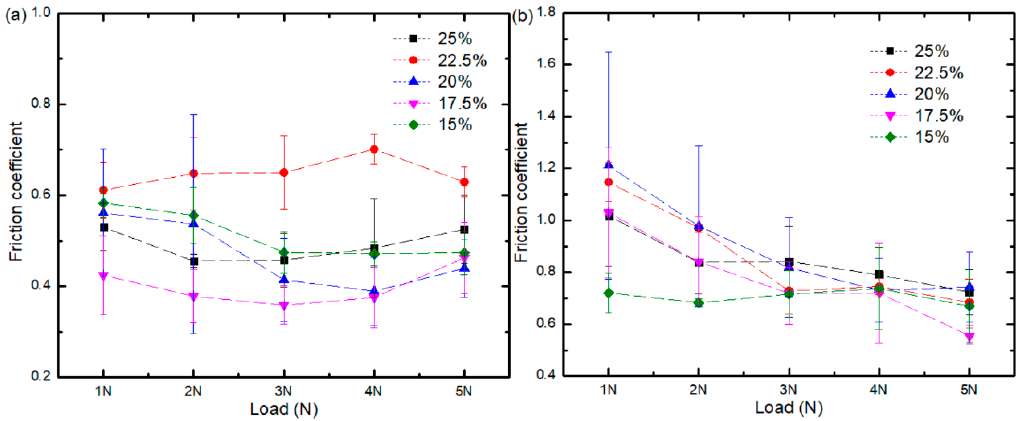
Figure 8. Variation curves of the friction coefficient of composites with different solid phase content: ( a ) Water-based drilling fluid; ( b ) Dry friction.